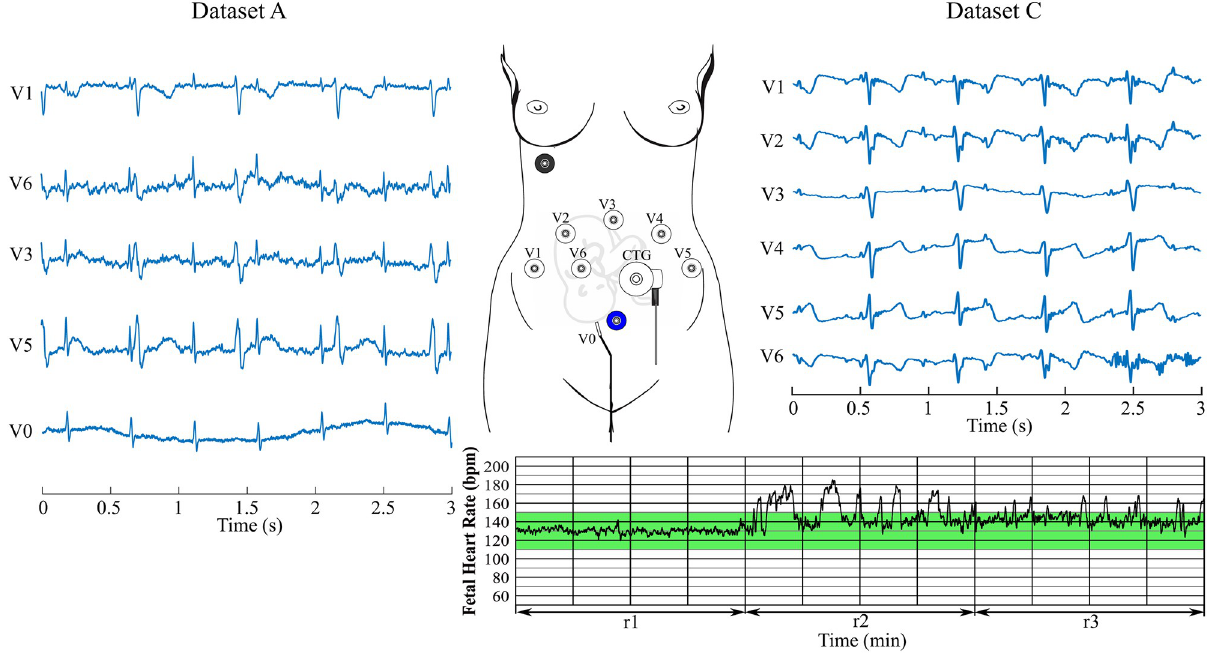
Fig 2. Electrode placement and examples of real signals from the datasets. A (ADFECGDB, abdominal ECGs and direct fECG from FSE) and C (Own data—abdominal ECGs and CTG trace).